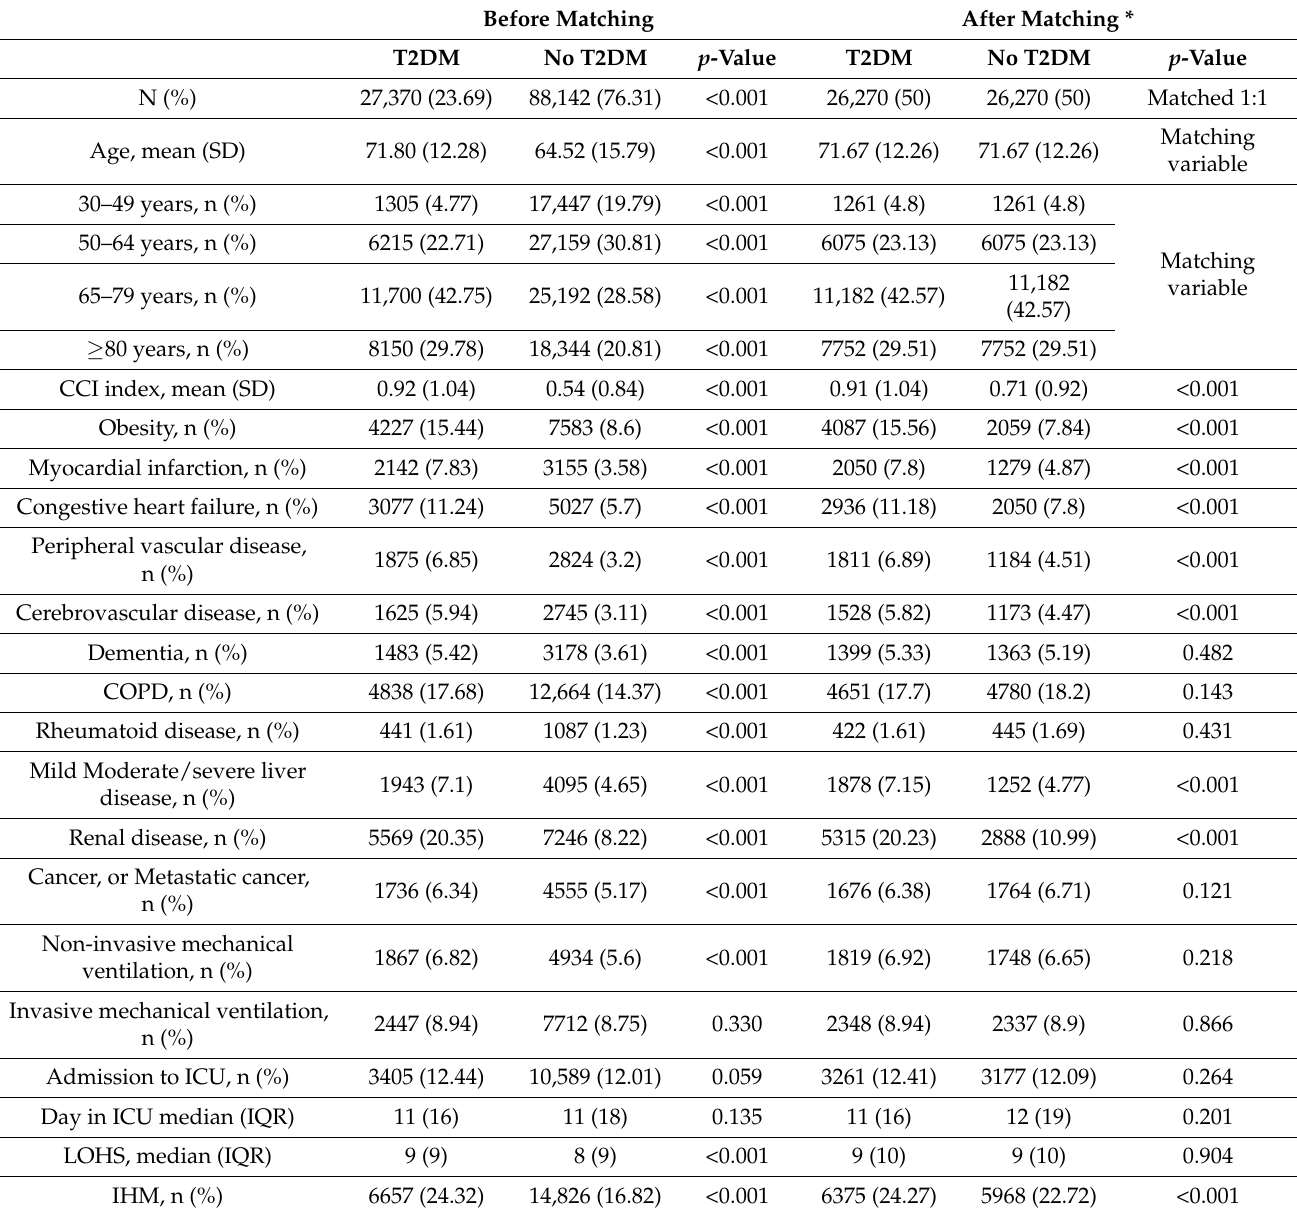
Table 3. Distribution of study covariates and hospital outcomes, before and after matching, for men hospitalized for COVID-19 in Spain in the year 2020 according to T2DM